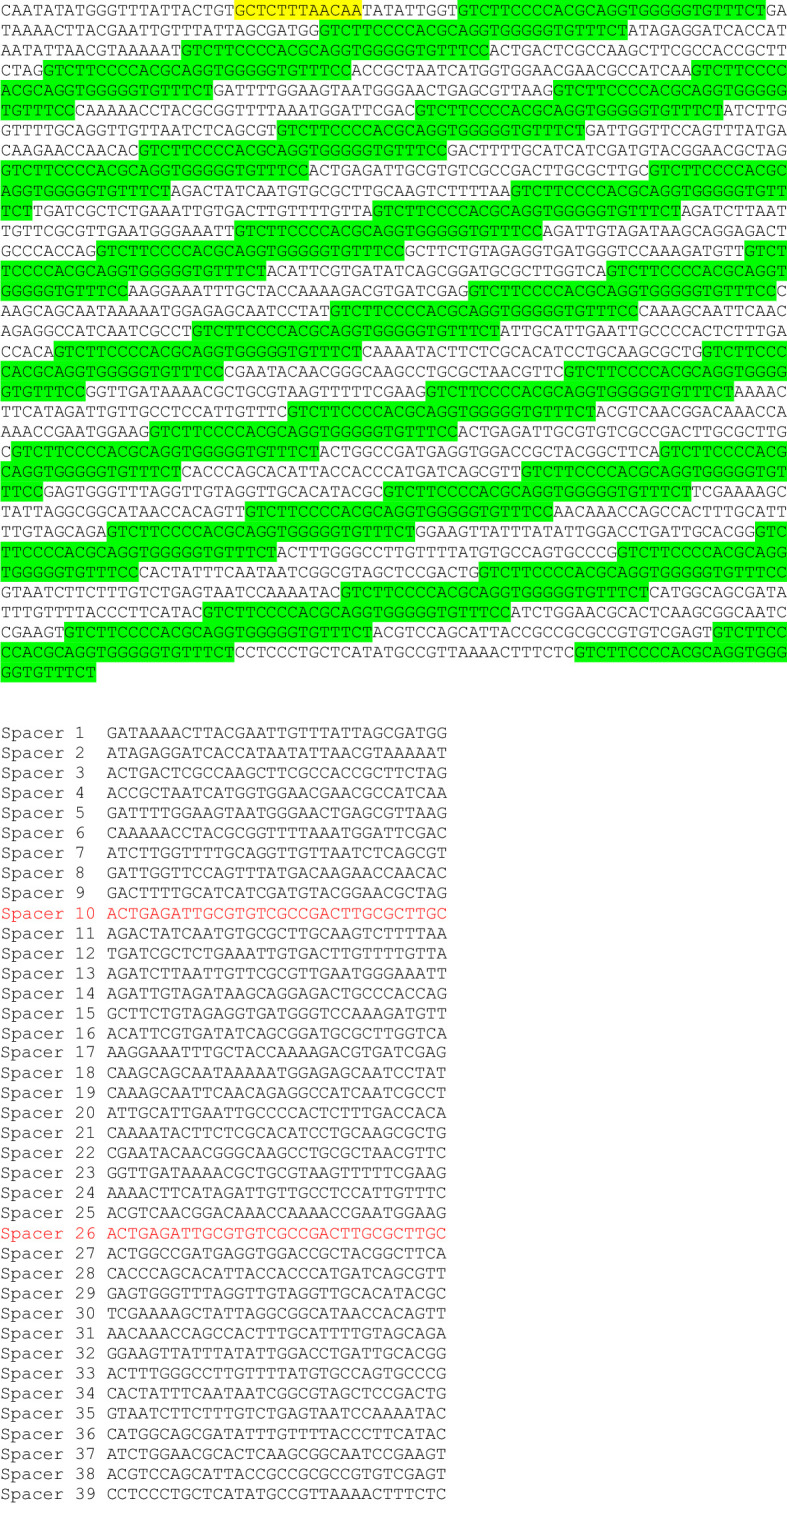
Sequence of the CRISPR array and upstream sequence from Vibrio cholerae A50.The first nucleotide shown is the first nucleotide downstream of cas2. Repeat sequences are highlighted in green. The boxA sequence is highlighted in yellow. Individual spacers and their position in the array are indicated below the sequence of the array. The red highlighted spacers are identical.